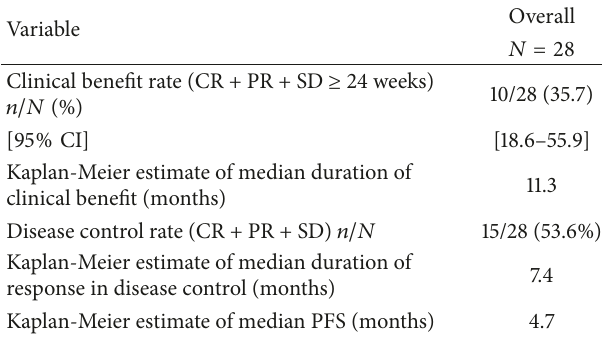
Table 3: Efficacy results of VICTOR trial in the TNBC population.